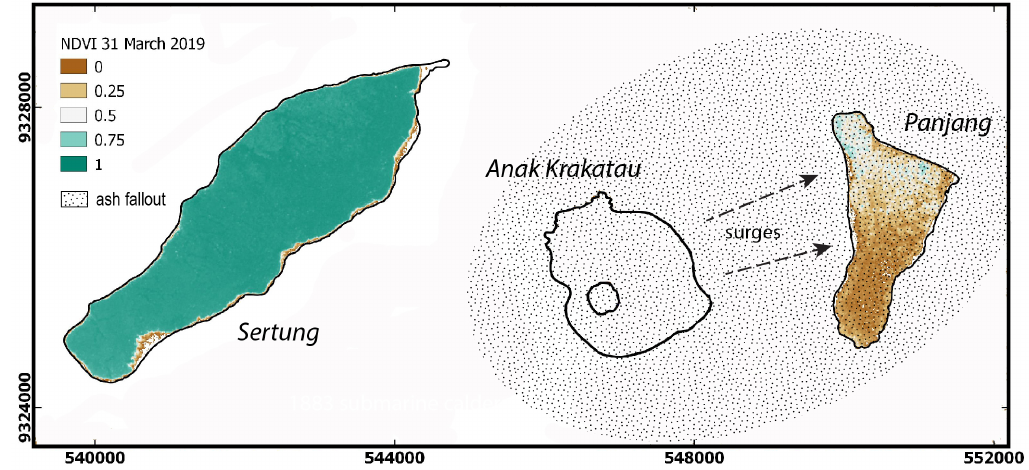
Figure A2: NDVI (Normalized Di ff erence Vegetation Index) calculated from bands 4 (red) and 8 (NIR) of a Sentinel-2B image captured on 31 March 2019, showing loss of vitality of vegetation on Panjang Island due to successive ash plume fallouts and pyroclastic surges after the 22 December 2018 flank collapse (as shown on photographs captured on 23 December